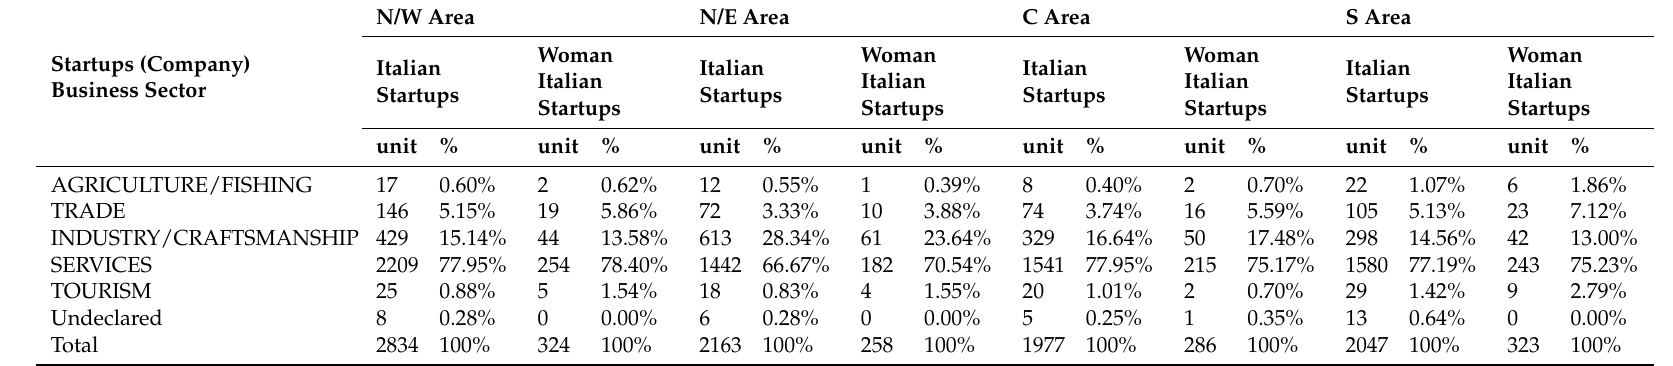
Table 10. Business sector of Italian startups and Italian woman startups for geographical